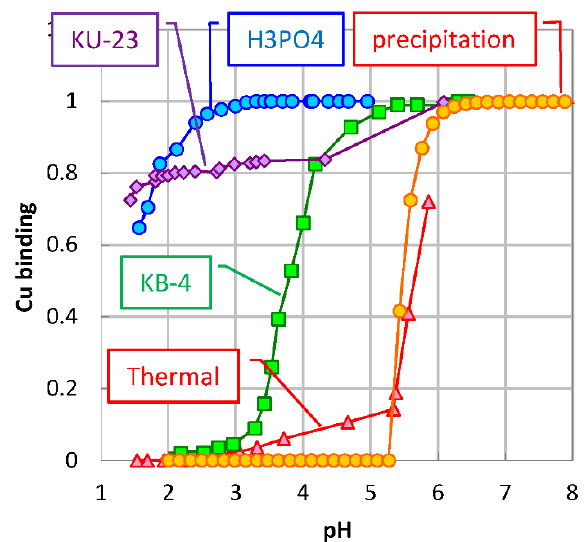
Figure 10. Copper binding by polyimide-derived carbons obtained with (H 3 PO 4 -series) and without (Thermal-series) phosphoric acid at 800 °C. Copper binding by ion-exchange resins with carboxyl (KB-4) and sulfo groups (KU-23) is provided for comparison.